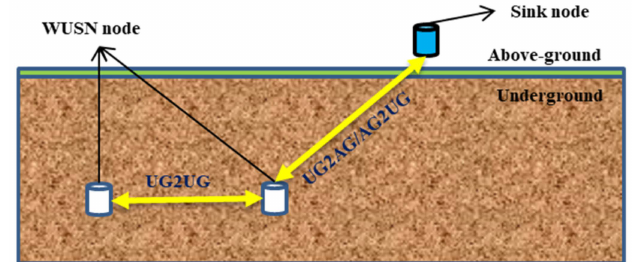
Figure 1. WUSN communication